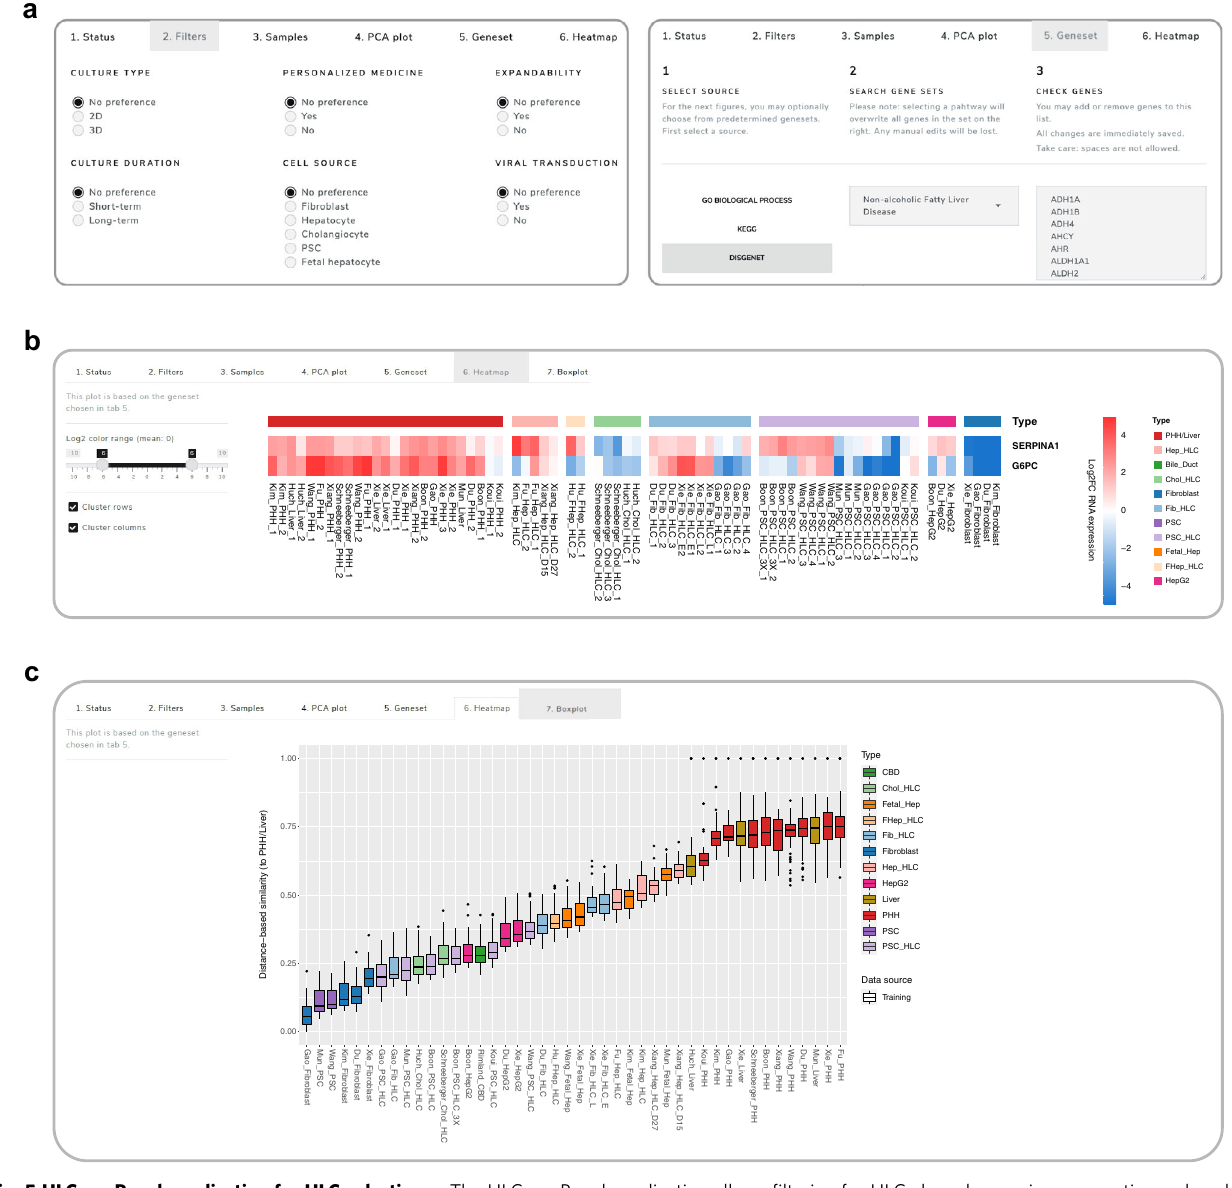
Fig. 5 HLCompR web application for HLC selection. a The HLCompR web application allows fi ltering for HLCs based on various properties and enables easy selection of gene sets relevant to hepatic functions and diseases. b Heatmap showing the relative expression of SERPINA1 and G6PC between samples. c Boxplot showing DBS of non-alcoholic fatty liver disease-associated genes according to the DisGeNET database. Box-and-whisker plots are shown as median (line), interquartile range (box), and data range or 1.5x interquartile range